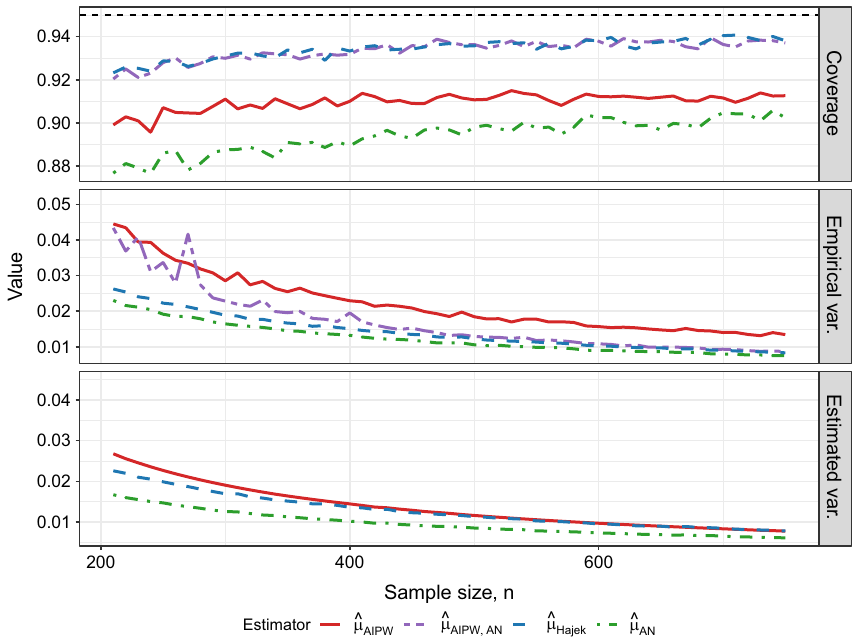
Figure 4: Coverage of 95% con fi dence intervals for di ff erent estimators of the mean μ of Y 1 k ( ) in the normal model ( 18 ) when μ θ 1, 0.1 = = , and n varies, along with empirical variances and estimated variances based on asymptotics. We see in